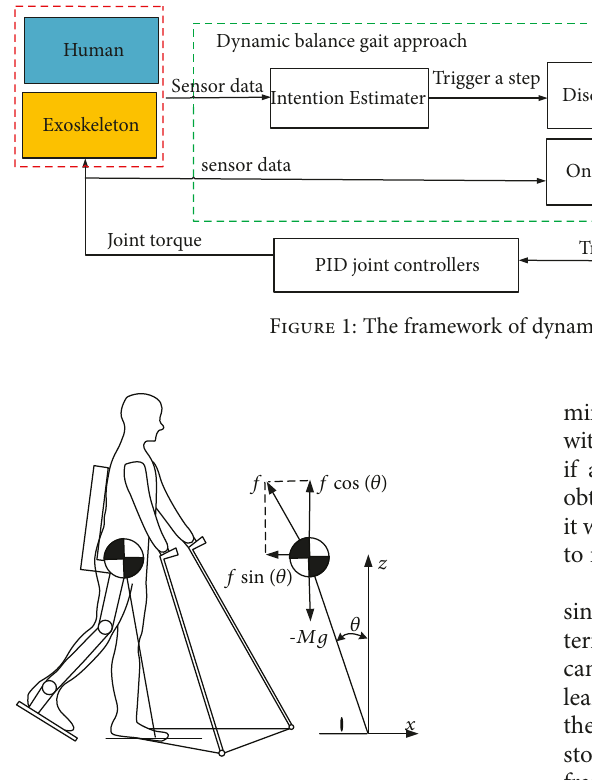
Figure 2: Model of exoskeleton and human based on